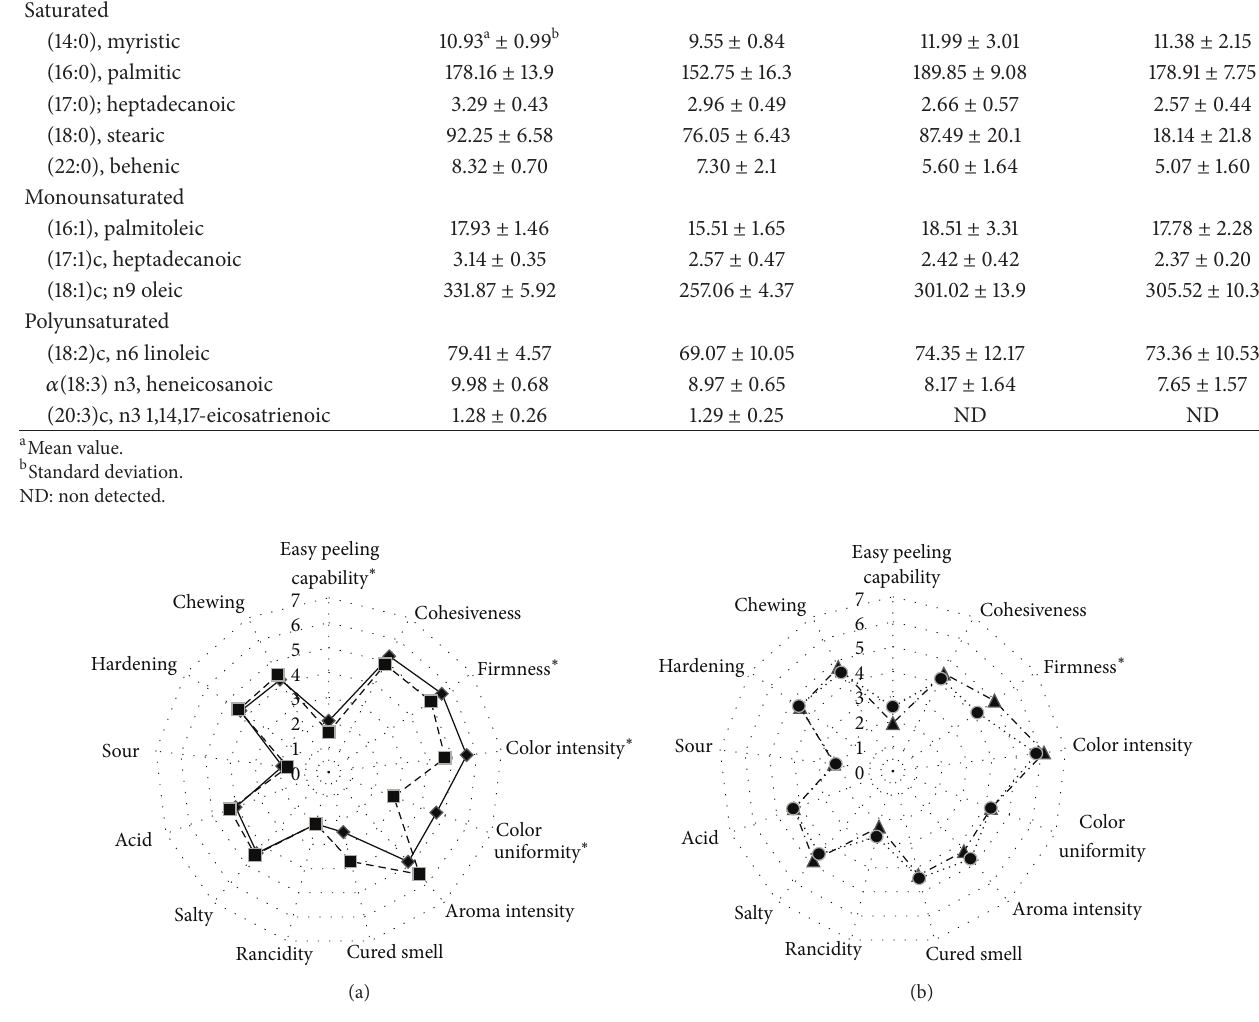
Figure 3: Effect of autochthonous starter cultures on the sensory attributes of fermented sausages. (a) Comparison between SAS-1 and its control system C-1. (b) Comparison between SAS-2 and its control system C-2. Systems: X - X : SAS-1 ( Lactobacillus sakei 487 + Staphylococcus vitulinus C2); ◼ --- ◼ : C-1 (noninoculated control system simultaneously manufactured with SAS-1); 󳵳 - ⋅ - 󳵳 : SAS-2 ( L. sakei 442 + S. xylosus C8); e ⋅⋅⋅ e : C-2 (noninoculated control system simultaneously manufactured with SAS-2). ∗ Significantly different ( 𝑃 < 0.1